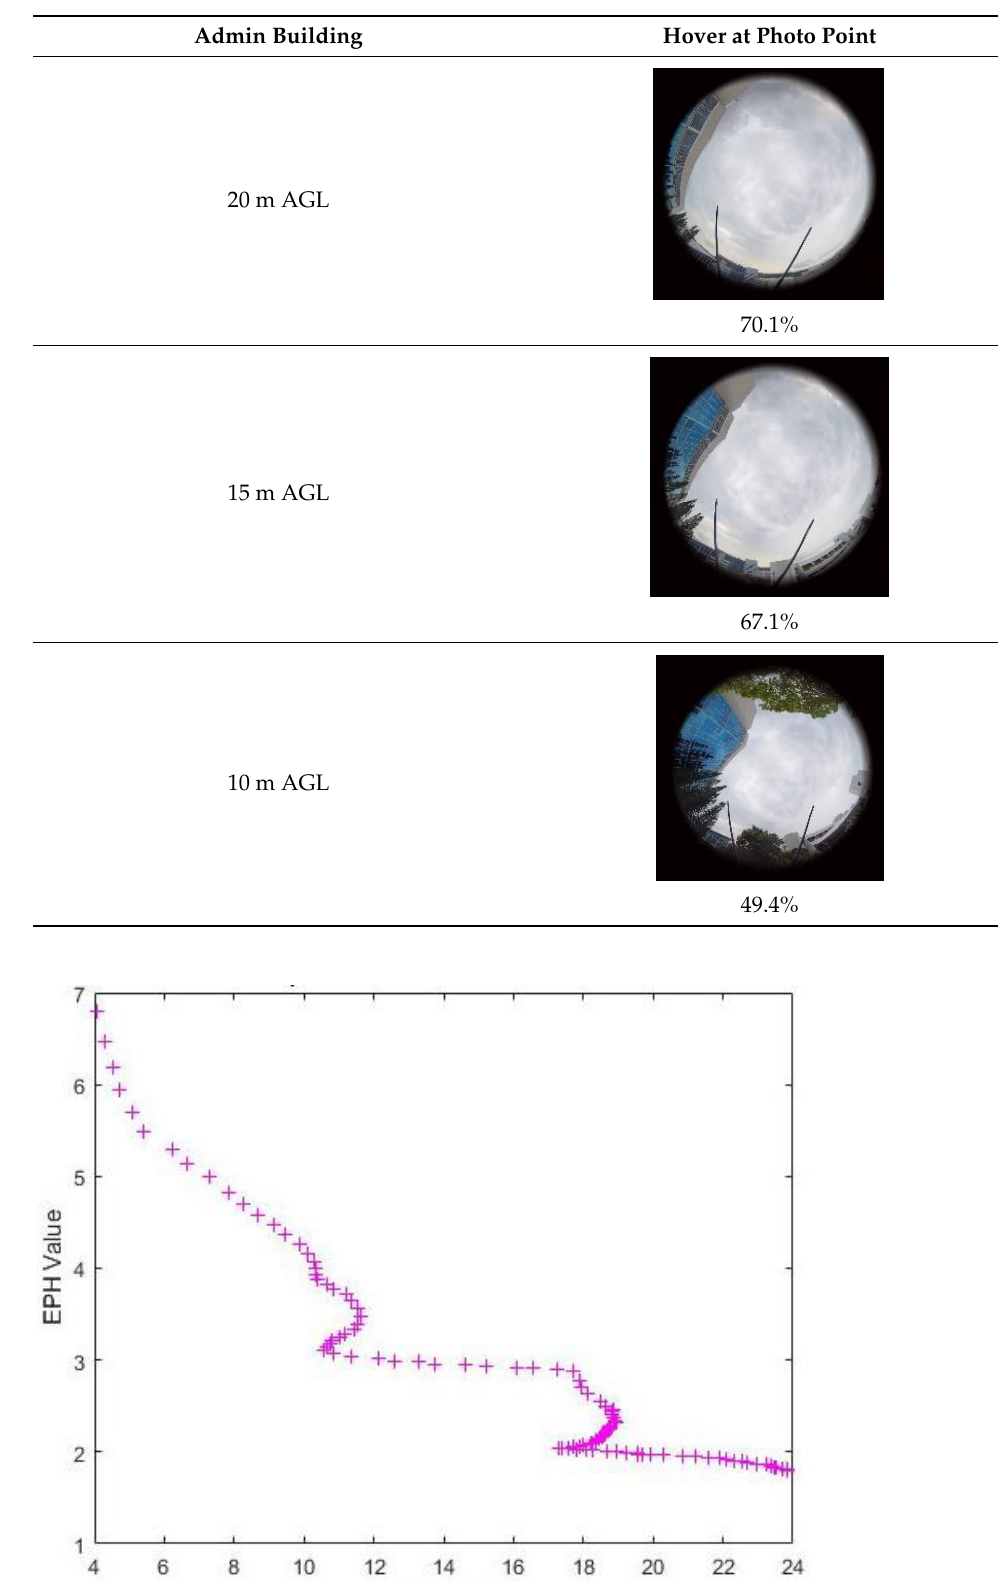
Figure 22. Boxplot of Measured Horizontal Error versus Sky Ratio at the Admin Building. 5. Conclusions The initial observation by analysing the flying test results obtained showed that the number of satellites visible to the UAS increases as the mission altitude increases in an urban-like environment. A preliminary analysis of the measured horizontal error reported by the GPS receiver also showed a similar trend of increasing accuracy with increasing altitude [33]. This observation led to the hypothesis that the physical line-of-sight blockage of the GNSS signal is the dominant factor affecting horizontal accuracy in urban environ- ments. If true, this would imply that the GNSS-based navigation performance in the entire urban airspace could be estimated for use in UAS traffic management, thus enabling nav- igation performance differentiated traffic flow. To accomplish this, the determination of actual horizontal error between the GPS reported position and some ground-truth refer- ence at various locations and altitudes was needed. Additionally, the use of horizontal covariance (EPH) reported by the GPS receiver as an indicator for navigation performance monitoring for PBN conformance was also investigated. The measurement of horizontal position error using GNSS navigation was performed by collecting GPS and RTK data at four different locations: Carpark F, N2.1, N3.2 and the Admin Building on the NTU campus. Measurements were taken at each location at three different altitudes: 10 m, 15 m and 20 m above ground level. The data was collected using the Here GPS and Here+ RTK receiver installed on a self-built drone with an additional